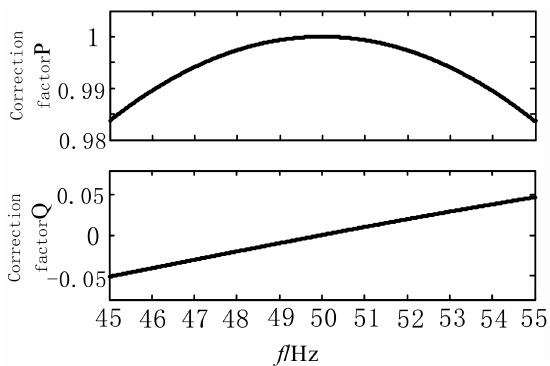
Figure 1. Change curve of the calibration factor P and Q with respect to